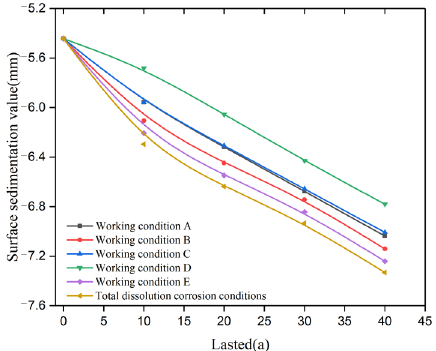
( d ) Forty years of dissolution Figure 14. Comparison of surface longitudinal settlement curve patterns caused by dissolution degradation at different locations and shown for a given time. The variation in the maximum value of surface settlement with the dissolution cycle under different dissolution conditions is shown in Figure 15. From the figure, the fol- lowing patterns can be found: (1) The closer the location of culvert damage is to the bottom, the greater the value of surface settlement caused, and the maximum value of surface settlement caused by dissolution at the bottom is about 20% more than that at the top. (2) The width and settlement value of the surface settlement trough shows a nonlinear increase with the increase in the degree of dissolution, which is mainly divided into three stages: The first stage is 0~15 years, where the degree of concrete dissolution is small, the decrease in permeability coefficient is small, the culvert does not show leakage, and the main cause of soil settlement is the decrease in concrete elastic modulus. The second stage is 15~30 years, where the settlement increase rate grad-